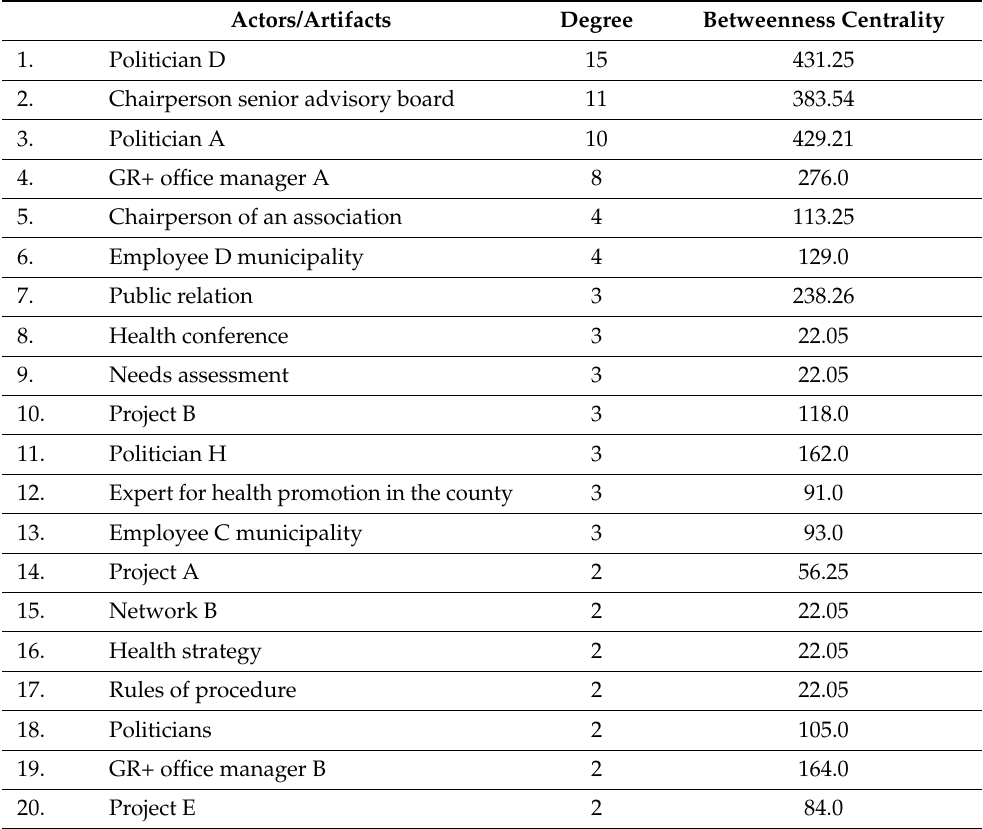
Table 3. Degrees and betweenness centrality as measured from the perspective of the steering committee; displayed are only actors with a betweenness centrality > 0; Density =